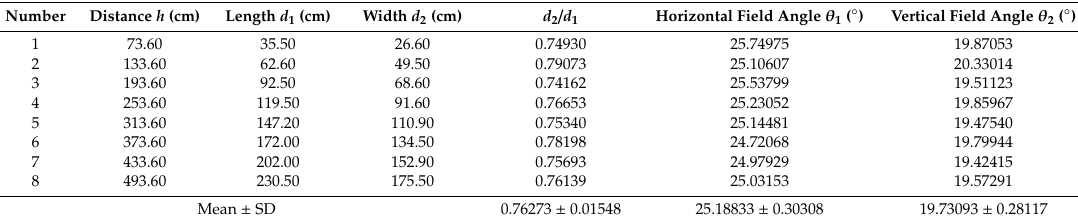
Table 2. Variation of the field-of-view